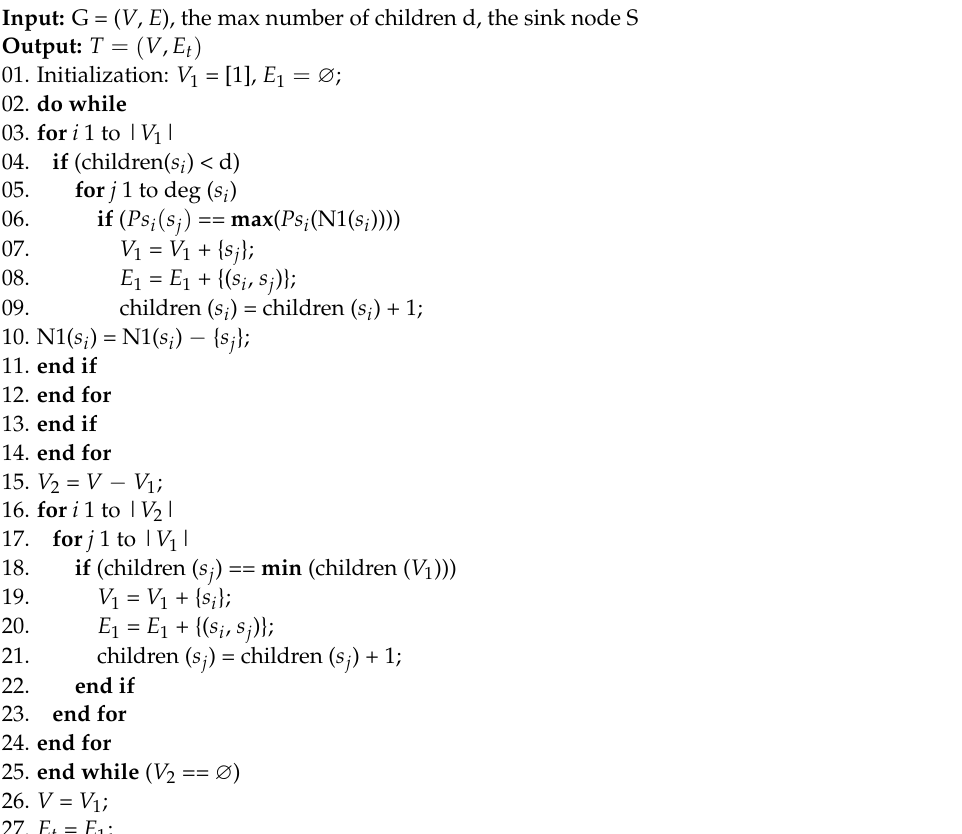
Algorithm 1. Construction of routing